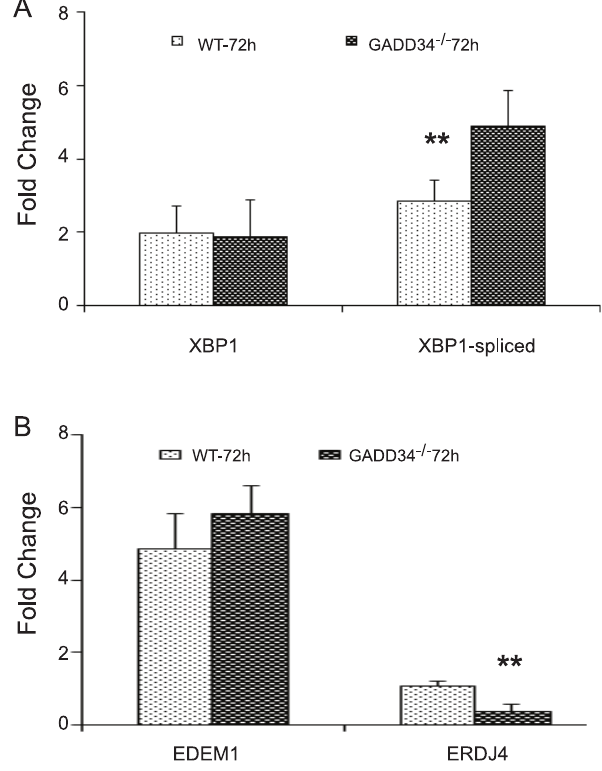
Figure 4. Expression of spliced XBP1 and its downstream target genes. qRT-PCR data shows significant differences in transcript levels of spliced XBP1 (A) and ERDJ4 (B) in GADD34 -/- mice compared to WT mice at 72 hours